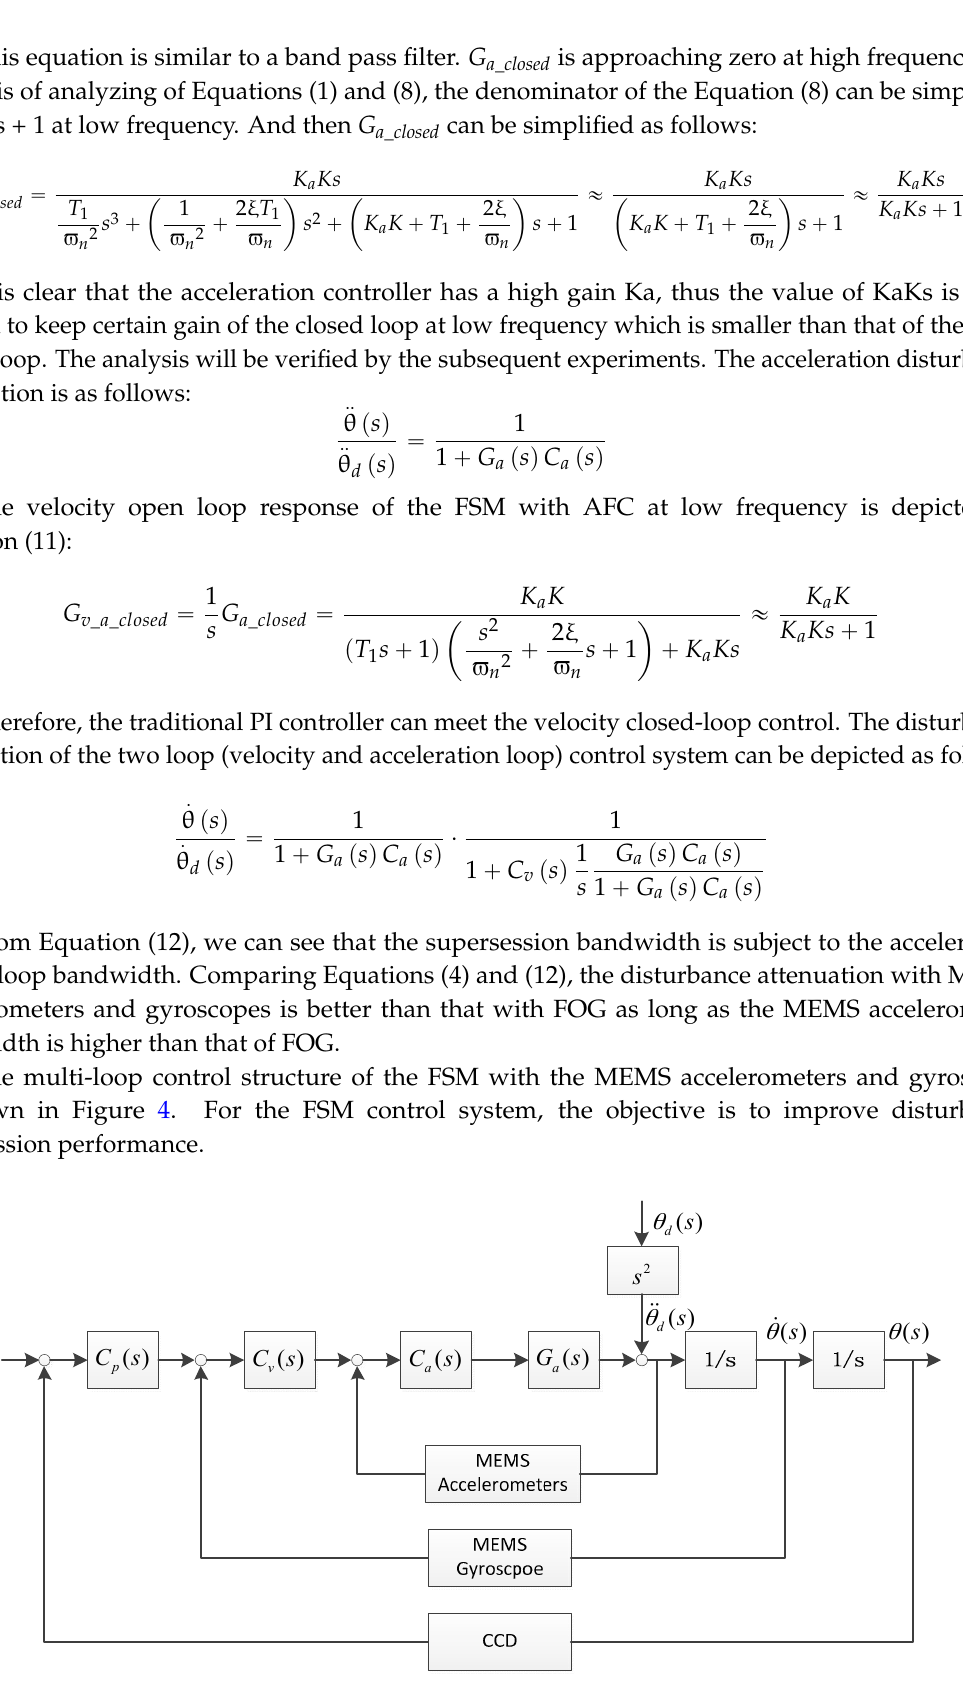
Figure 4. Stabilization control structure of multiple closed loops.